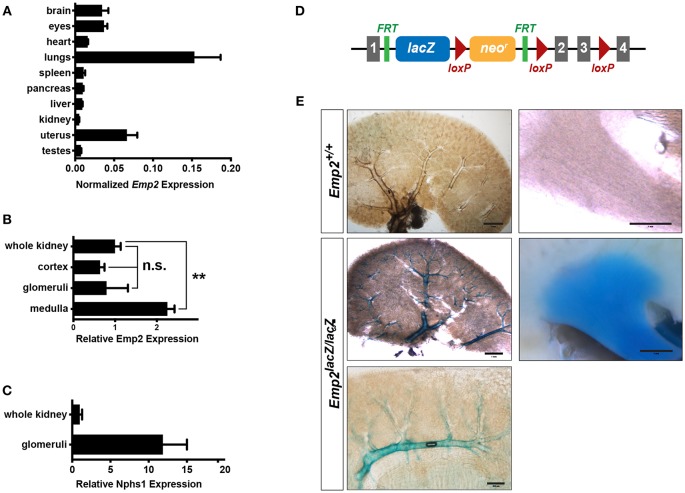
Renal expression of Emp2. (A) Survey of tissue expression of Emp2 by qRT-PCR analysis. Emp2 transcript levels were normalized to that of Gapdh. n ≥ 3 animals per group. (B)
Emp2 expression is not particularly enriched in glomeruli. Comparison of Emp2 transcript level normalized to Gapdh relative to whole kidney expression in renal cortex, purified glomeruli, and renal medulla. n = 3 animal per group. **P < 0.005 (C)
Nphs1 expression is enriched in glomeruli. Comparison of normalized Nphs1 level between purified glomeruli and whole kidneys. n = 3 animal per group. (D) Schematic diagram of the in vivo Emp2 expression reporter construct used in this study. A dual lacZ-neomycin resistance cassette was inserted between exons 1 and 2 in the Emp2 locus to create the Emp2lacZ reporter allele, where β-galactosidase (β-gal) expression is driven by the endogenous mouse Emp2 promoter. The conditional floxed allele of Emp2 (Emp2flx) was subsequently derived from this reporter construct. Gray boxes, Emp2 exons; green ticks, FRT or Flp recombinase recognition sites; and red triangles, loxP or Cre recombinase recognition sites. (E)
Emp2 expression pattern in the kidney. Comparison of Emp2 promoter activity (based on β-gal histochemical staining) in vibratome slices of kidneys from control (Emp2+/+) and Emp2lacZ reporter mice revealing strong Emp2 expression localized to medium and high-caliber renal vessels and also the renal medulla. Scale bars: 2 mm, middle left panel; 1 mm, upper left/right panel, middle right panel; 200 μm lower panel.